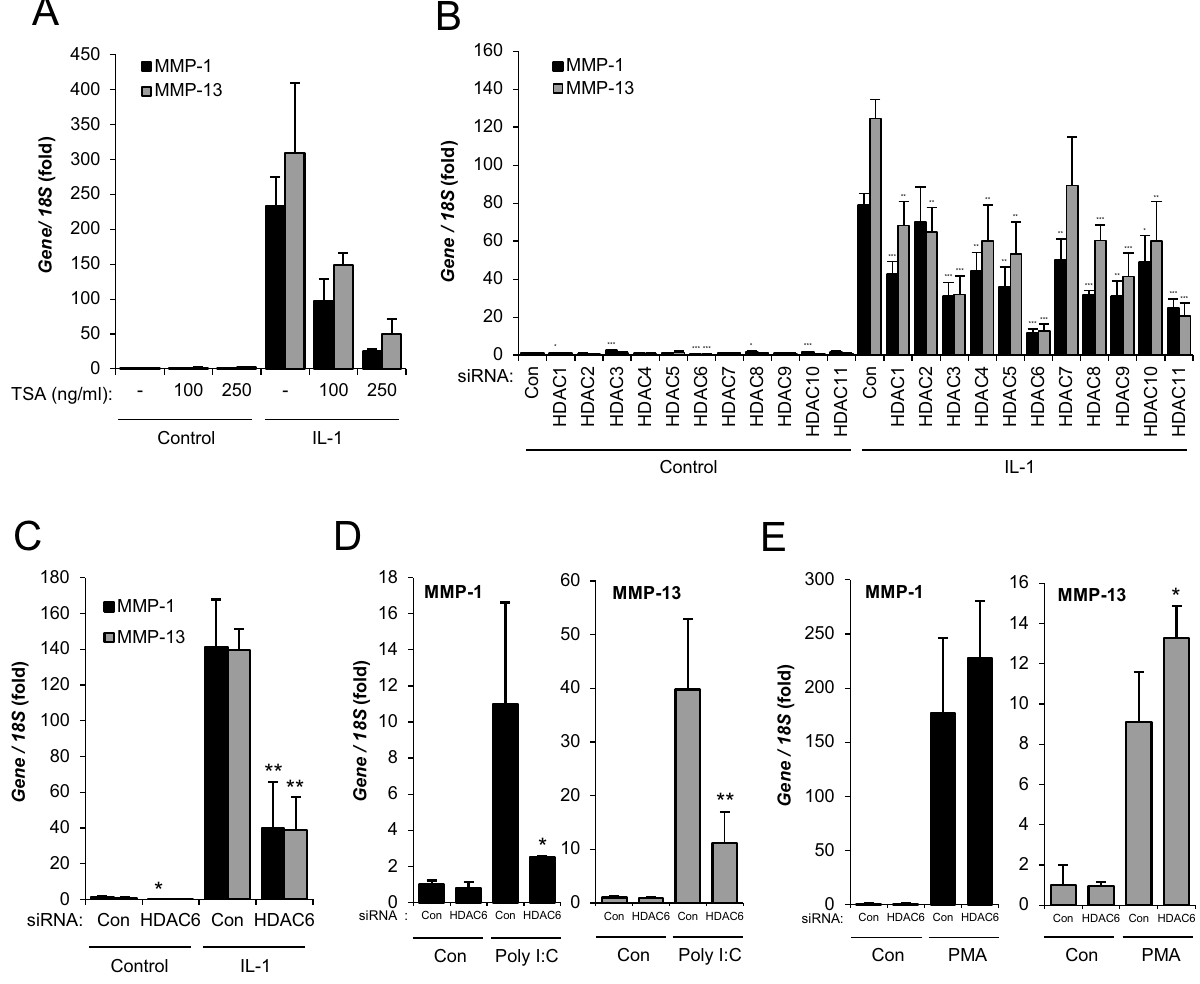
Figure 1. Effect of HDAC6 depletion on MMP gene expression in SW1353 cells. ( A ) SW1353 cells were stimulated with IL-1 for 8 h in the presence of TSA at the indicated concentrations. RNA was extracted and expression of MMP1 and MMP13 measured by real-time RT-PCR normalised to 18S . ( B ) SW1353 cells were transfected with the indicated HDAC-targetting siRNAs for 24 h prior to stimulation with IL-1 for 8 h. ( C – E ) SW1353 cells were transfected with Dharmacon HDAC6-targetting siRNA for 24 h prior to stimulation with ( C ) IL-1, ( D ) Poly I:C or ( E ) PMA for 8 h. A was performed in duplicate and B – E were performed in quadruplicate. Data are presented as fold induction relative to the basal expression and represent mean ± S.D. (* p < 0.05, ** p < 0.01, *** p < 0.001). Data are representative of a minimum of three independent